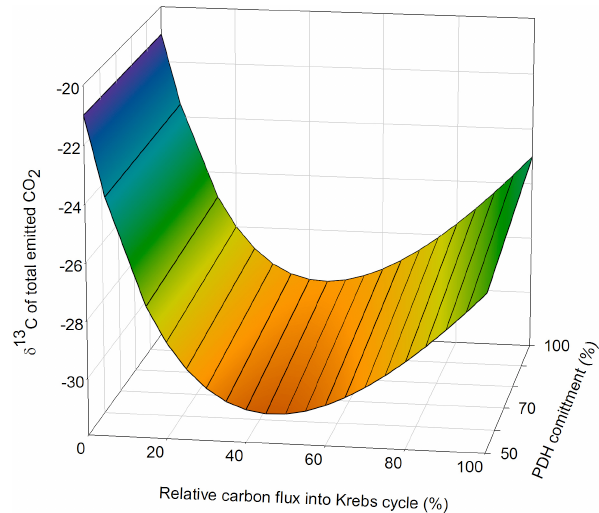
Figure 7 2 Fig. 7. Theoretical isotopic fractionation effects during decarboxy- lation of pyruvate. The theoretical effects were calculated utilizing a simple mass balance equation, through adding the flux-weighted isotope ratios of each carbon position (C-1-3): δ 13 C res =[ f 1 · δ 13 C-1+ f 2 · ( δ 13 C-2 + ε eff ( CS ) ) + f 3 · ( δ 13 C-3 + ε eff ( KG ) ) ] / ( f 1 + f 2 + f 3 ) with f 1 - 3 being the carbon flux (where f 2 equals f 3 as both carbon atoms enter the KC as Acetyl-CoA moiety), and δ 13 C-1-3 the isotopic composition of the carbon molecules at the C-1 to C-3 positions of pyruvate and ε denotes the enzymatic iso- tope effect. The effective enzyme isotope fractionation ( ε eff ) in the KC of the citrate synthase ( ε CS ) and the α -ketoglutarate de- hydrogenase ( ε KG ) is dependent on the carbon flow in the KC (see − 1. Potential fractionation effects Hayes, 2001) by: ε eff = α 1 + ε · f were calculated by varying the carbon flow rates into KC ( f 2 , 3 ) from 0–100%, assuming fractionation factor of ε CS and ε KG of − 23‰ (see Tcherkez and Farquhar, 2005 and Fig. 5 for details). PDH could also potentially fractionate if the reaction is incomplete (Melzer and Schmidt, 1987) which would further deplete δ 13 C res , which was tested assuming f 1 of 50–100% (z-axis), but occurrence of the latter processes in vivo is